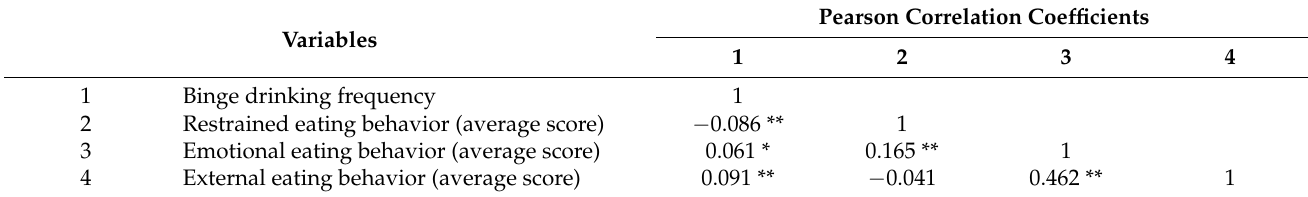
Table 2. Correlations among binge drinking frequency and obesity-related eating behaviors.